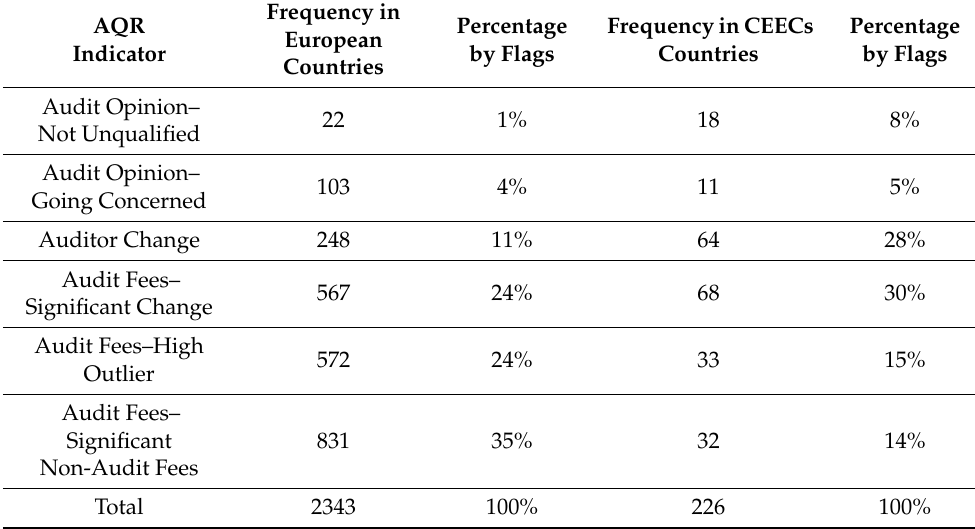
Table 3. AQR Indicator Frequency.